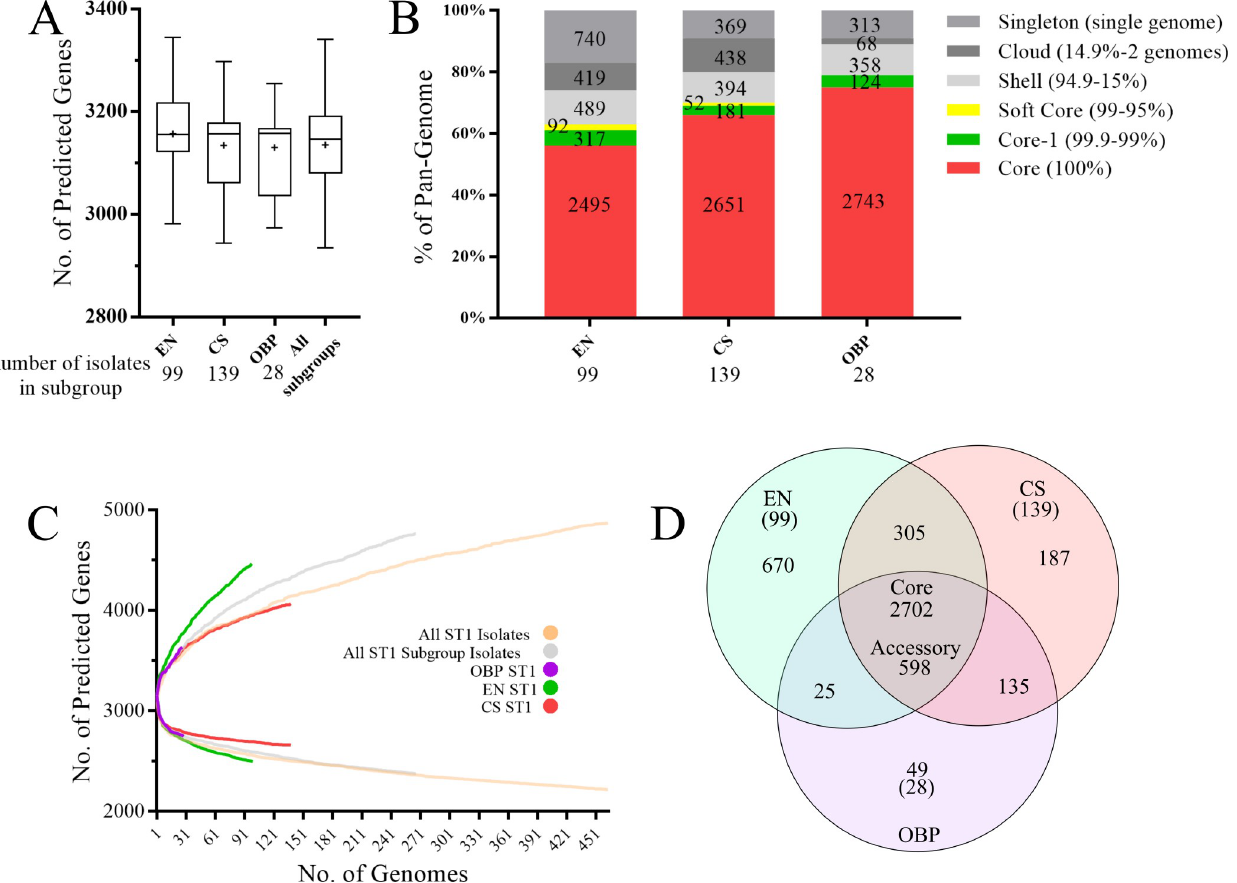
Fig 2. L . pneumophila ST1 isolate core and pangenome description and subgroup comparisons. A) Average number of predicted genes among EN, CS, and OBP subgroups. Box-and-whisker plots display the minimum, maximum, 25 th /75 th percentiles, median (horizontal line), and mean (plus sign) B) Predicted pangenome comparison. Gene frequency categories (to the right of the graph) are based, in part, on the ‘roary_plots’ output visualization of Roary, with the addition of a ‘Core-1’ category. Numbers within each stacked bar plot represent the gene count for each frequency category. C) Rarefaction curves for pan and conserved genomes. D) Direct comparison of predicted pangenomes showing the size of intersecting and unique accessory (non-core or core-1) genomes. The number of isolate genomes included in each subgroup is displayed either at the bottom of the subgraph (A and B) or in parentheses below the subgroup abbreviation (D). Abbreviations: ‘CS’, clinical sporadic; ‘EN’, environmental; ‘OB/OBP’, outbreak and potential outbreak associated.